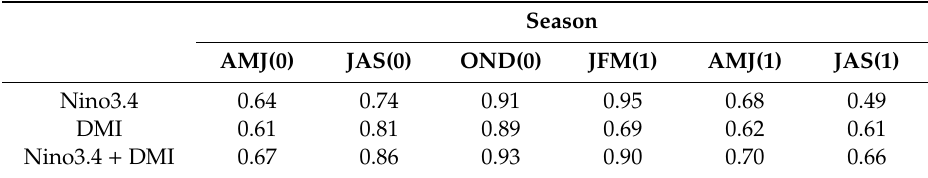
Table 2. The pattern correlation between the composite precipitation anomaly in combined years and the Nino3.4- and DIM-regressed precipitation anomaly as well as the sum of the regressed patterns during the six consecutive seasons,